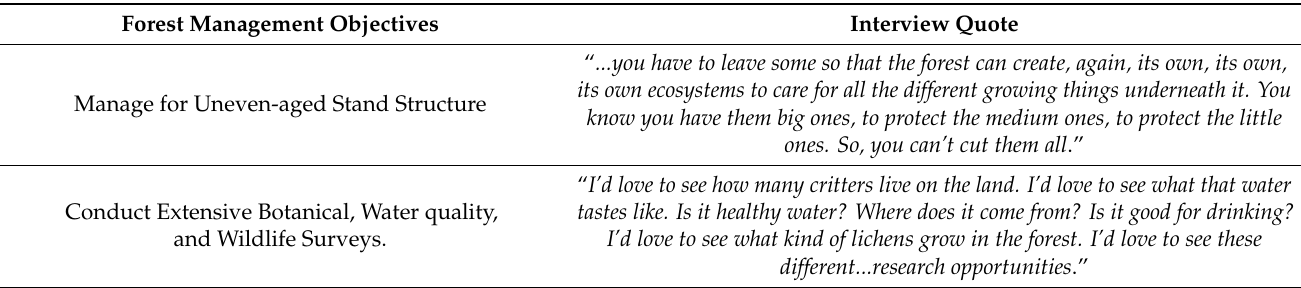
Table 3. Examples of quotes provided by participants and how they could be translated into forest management